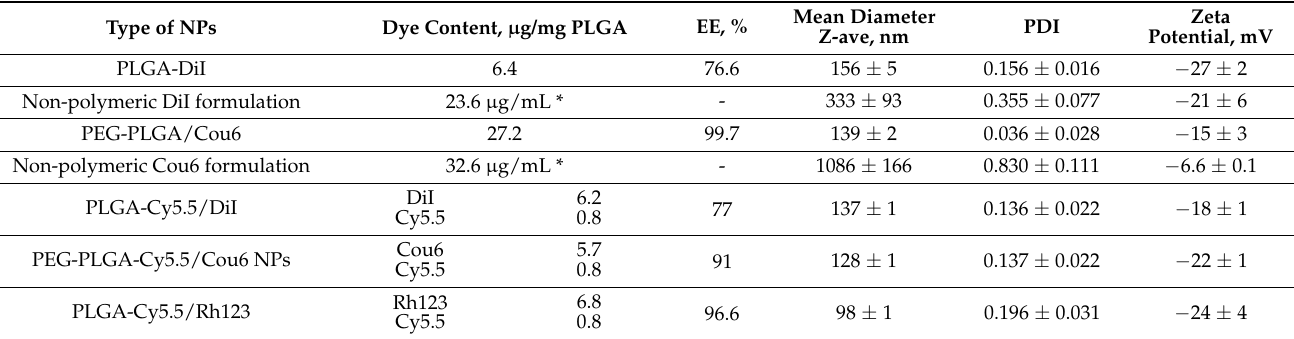
Table 5. Characteristics of fluorescent PLGA NPs used in in vitro experiments.